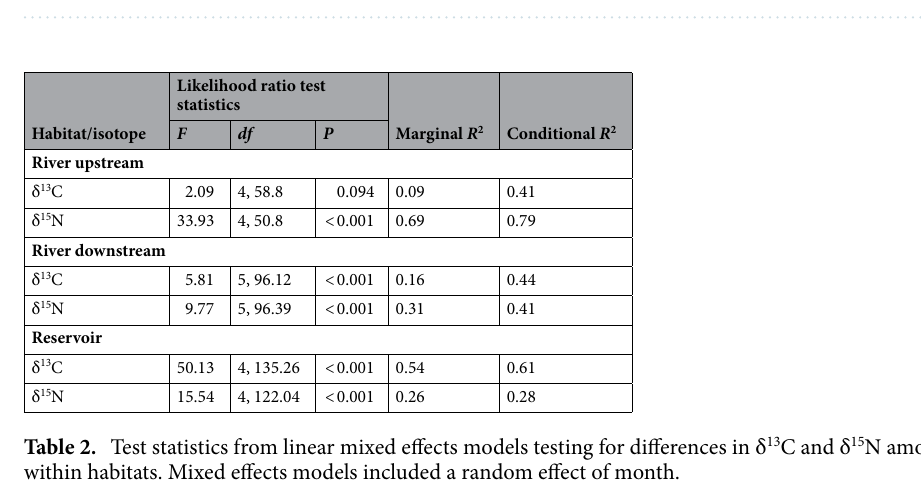
Table 1. Marginal mean estimates of δ 13 C and δ 15 N from linear mixed effects models, standard ellipse area corrected for sample size (SEAc), fish size (mm total length), and number of fish analyzed ( n ) from fishes captured in the San Juan River and Lake Powell, Utah. Native species are denoted with an*. Within habitats, species sharing letters did not differ (Tukey’s HSD: P > 0.05) in mean isotope values.